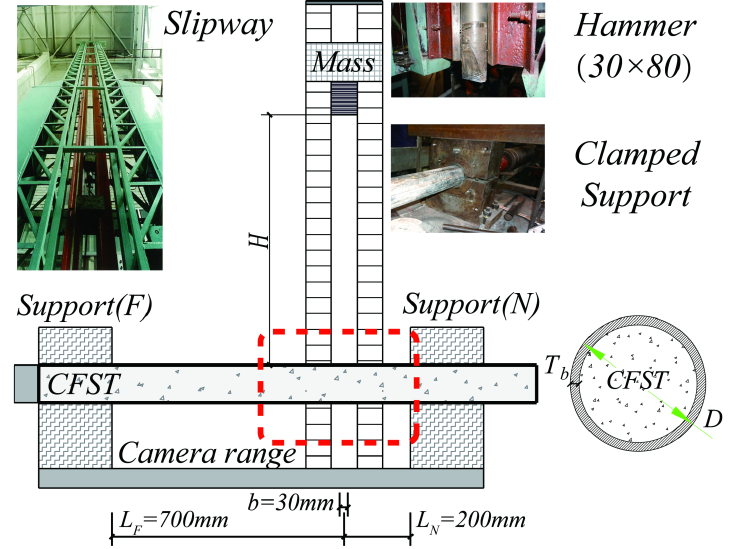
Figure 3. Impact loading information.